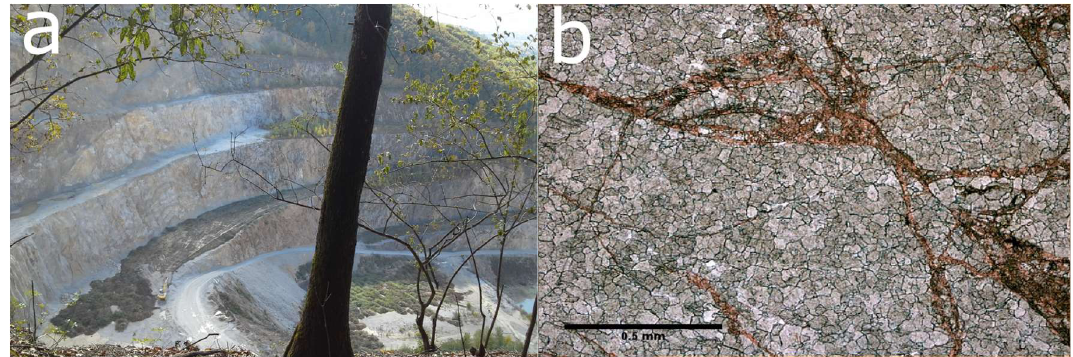
Figure 5. ( a ) Outcrop with light gray dolomite in the Medvednica mountains (Ivanec Quarry); ( b ) Photomicrograph of the brecciated light gray dolomite (The width of the microphotograph is 1.7 mm).